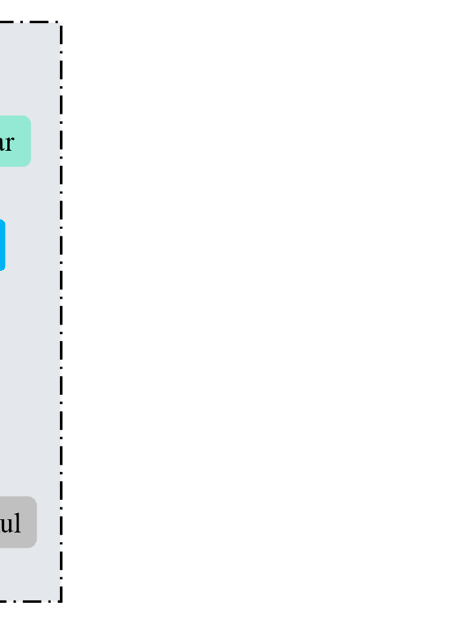
Figure 3. Process description of the attention mechanism to pay attention to the characteristics of the data features.